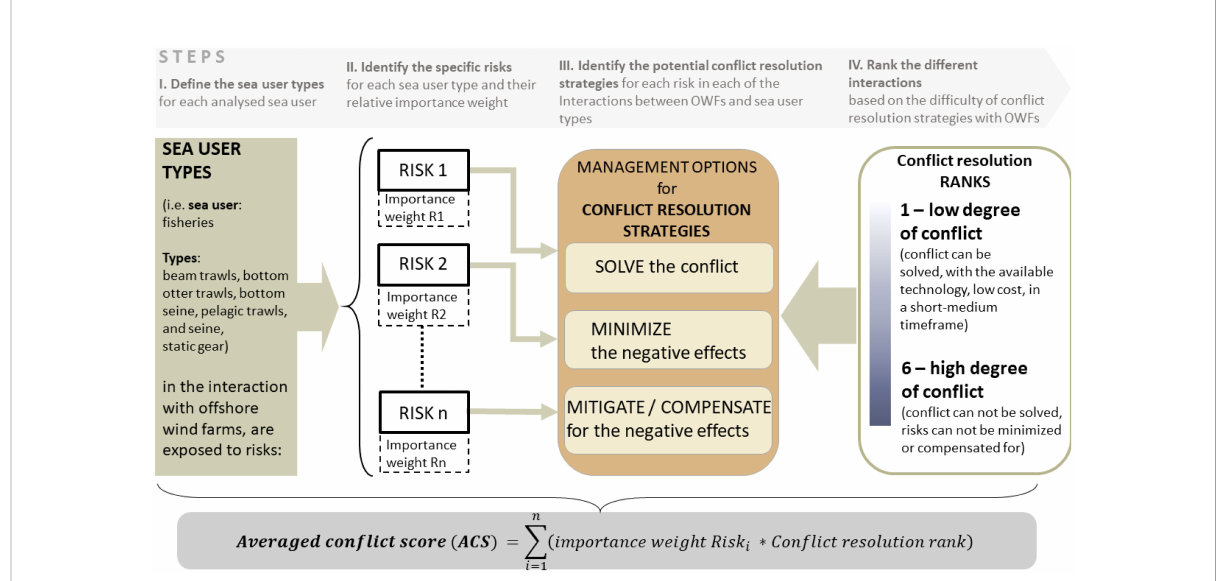
FIGURE 4 Framework of analysis to determine the con fl ict resolution rank (degree of con fl ict) for each speci fi c identi fi ed risk of the interaction between sea user types and